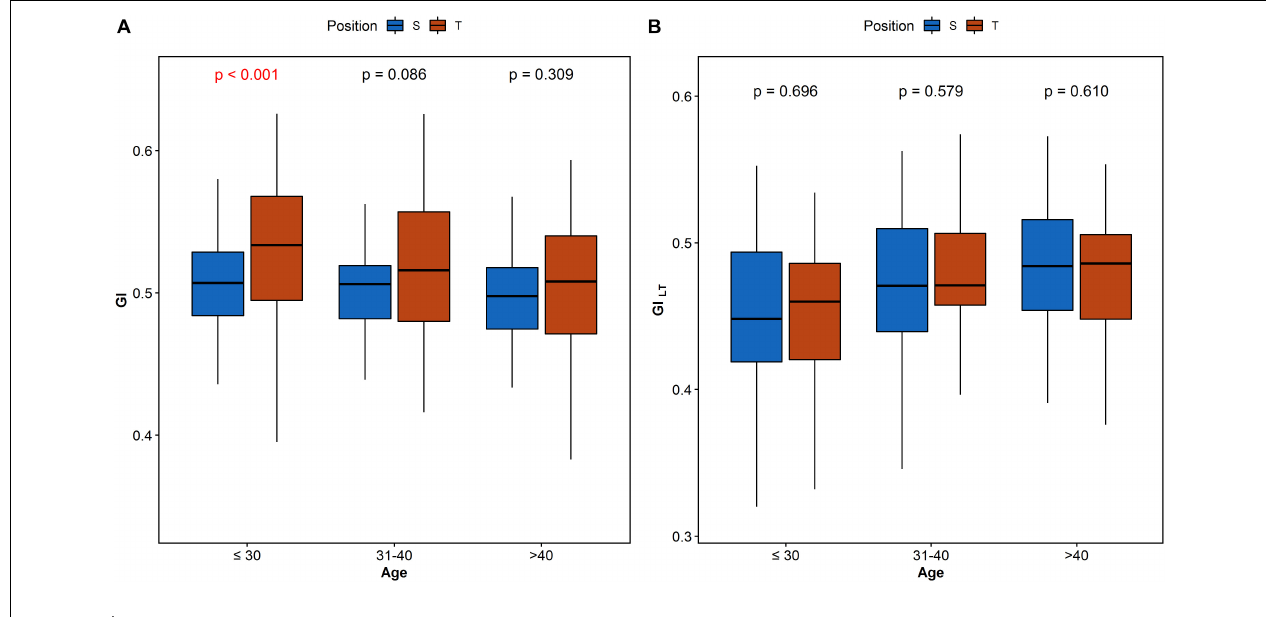
FIGURE 6 | Comparison of GI (A) and GI LT (B) between supine and tilt in each age group.